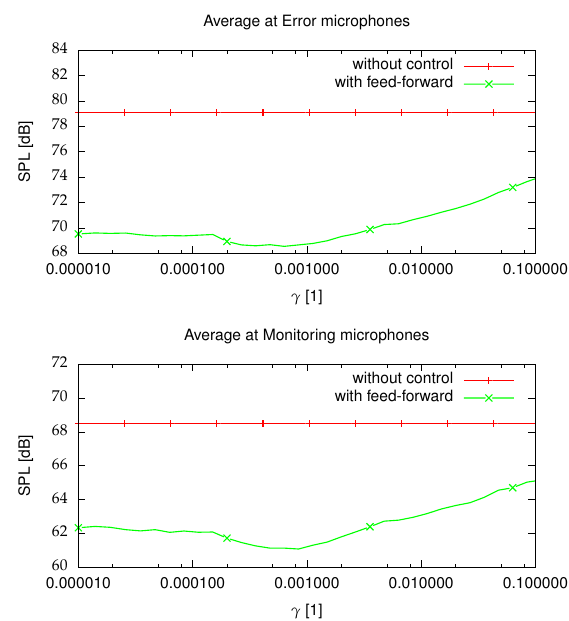
Figure 7. Average SPL at error and monitor microphones for reproduced spinning noise at 1200 rpm for a different γ after 15 minutes, µ = 0.001.